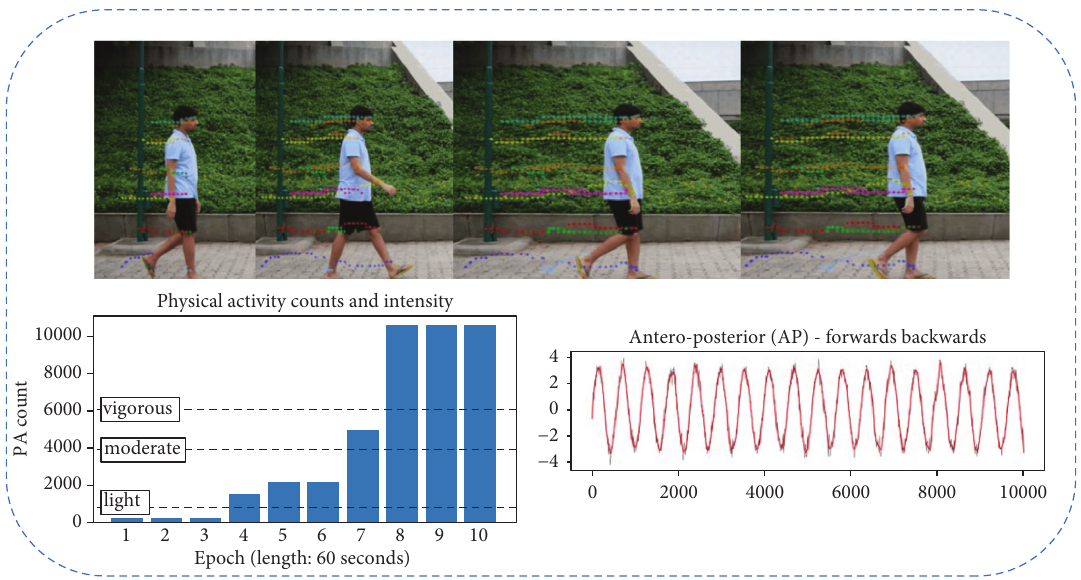
Figure 7: Testing on real-time feed with a plotting motion graph on gait patterns of knee